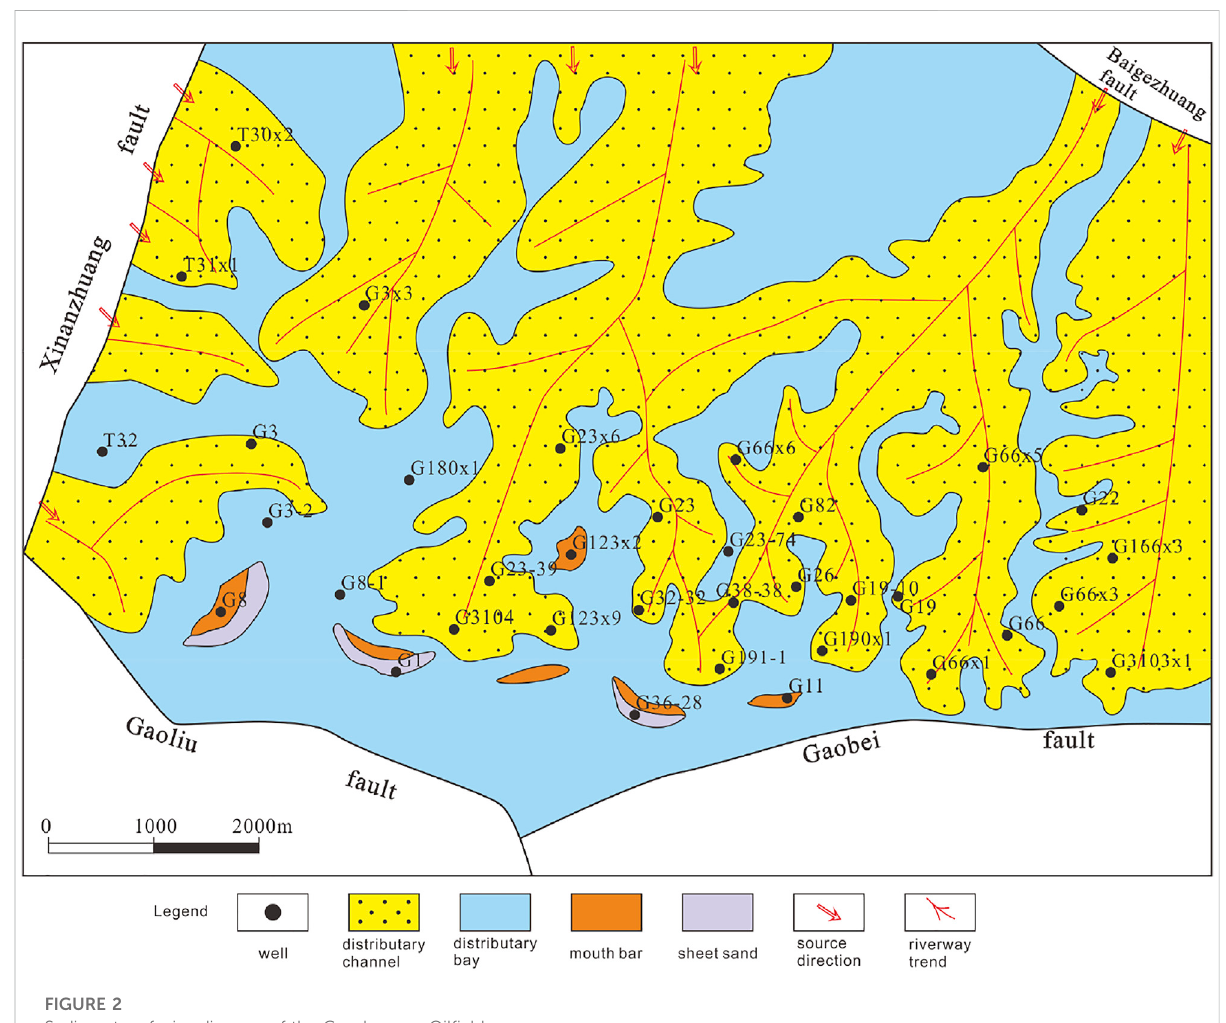
FIGURE 2 Sedimentary facies diagram of the Gaoshangpu Oil fi